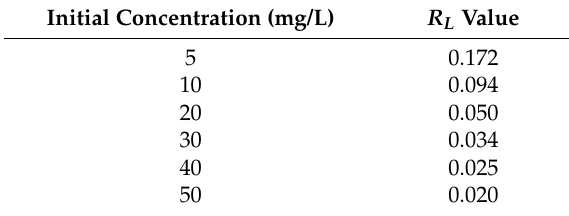
Table 7. The values of R L for the adsorption of Cd(II) ions by the nZVI/rGO composites.